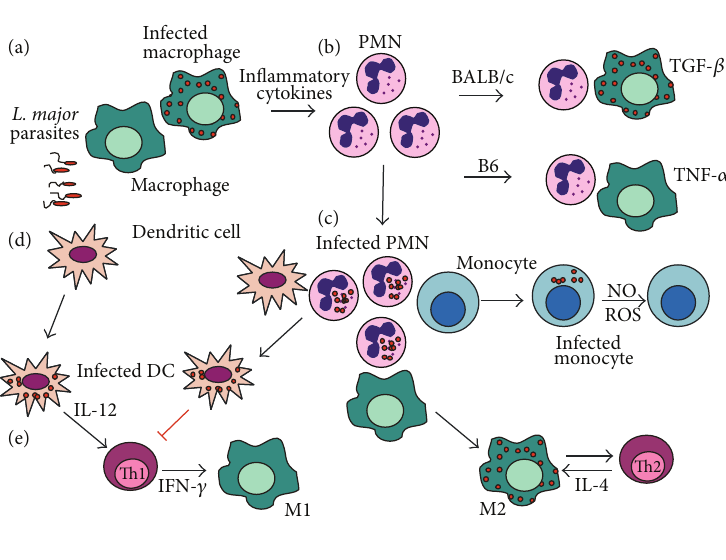
Figure 2: (a) Interactions among phagocytes in L. major infection. Upon L. major infection, tissue resident macrophages produce inflammatory cytokines and chemokines [4, 18] that recruit neutrophils and monocytes, which act as effector cells [31, 42] or give rise to inflammatory macrophages and DCs [30, 32]. (b) Neutrophils may either help or prevent parasite clearance by macrophages from B6 and BALB/c mice, respectively [3, 5]. (c) In addition, infected neutrophils help to propagate infection to macrophages, monocytes, and DCs [14, 41]. Moreover, macrophages primed by apoptotic neutrophils became permissive to subsequent infection and induce Th2 responses [21]. (d) DCs infected through efferocytosis of neutrophils fail to activate T lymphocytes [41]. Otherwise, infected DCs go to lymph nodes and induce Th1 responses [29, 32]. (e) Th1 cytokines activate M1 macrophages to kill parasites, whereas Th2 responses induce parasite-permissive M2 macrophages [6,